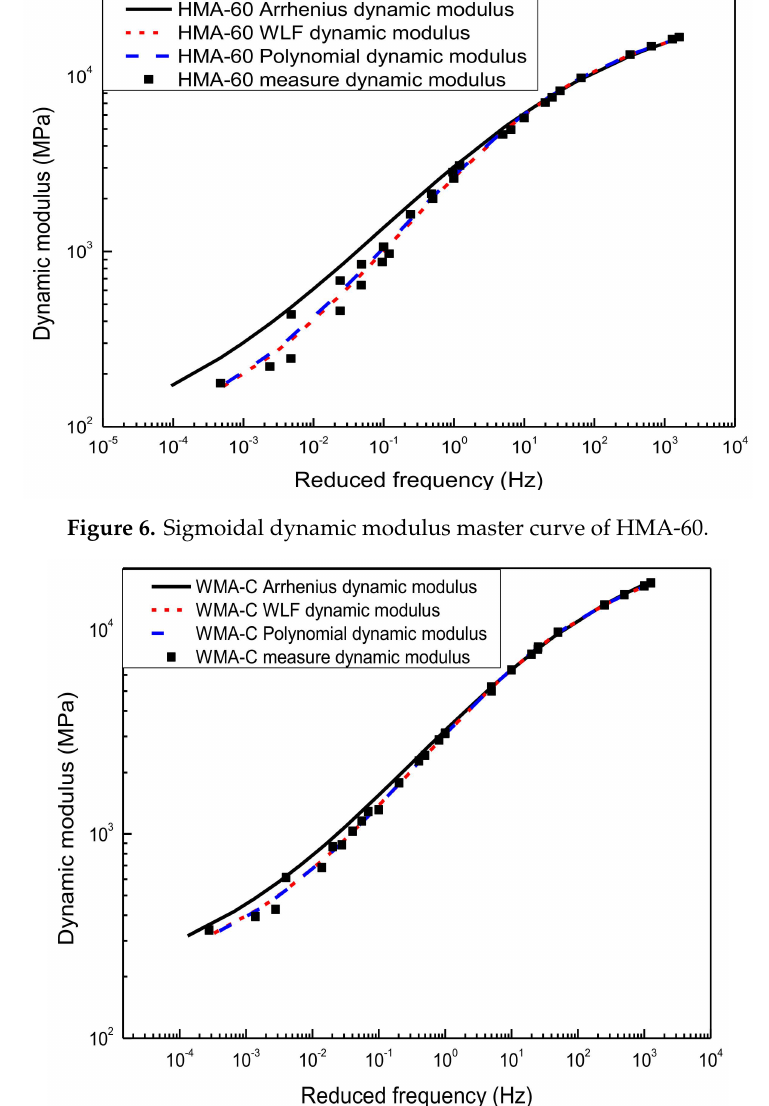
Figure 7. Sigmoidal dynamic modulus master curve of